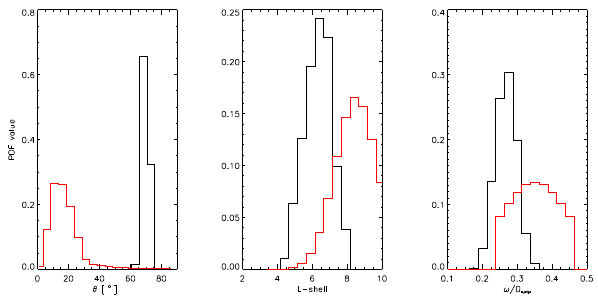
Figure 4. Probability distribution functions of wave-normal angle (left panel), L -shell (middle panel), and normalized frequency (right Fig.4. Probabilitydistributionfunctionsofwavenormalangle(leftpanel), L -shell(middlepanel)andnormal- panel) obtained from numerical simulations of chorus elements. ized frequency (right panel) obtained from numerical simulations of chorus elements. Statistical distributions Statistical distributions of initial rising tones (red) and falling tones ofinitialrisingtones(red)andfallingtones(black)arecompared. (black) are